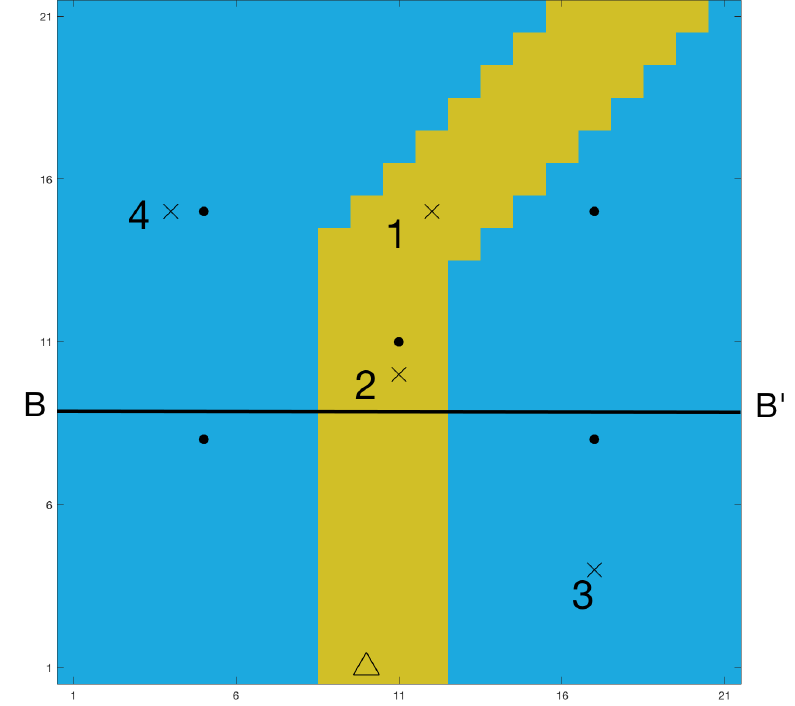
Figure 2. Initial log-diffusivity field with observation locations · , monitoring locations × , and heat source (cid:52)